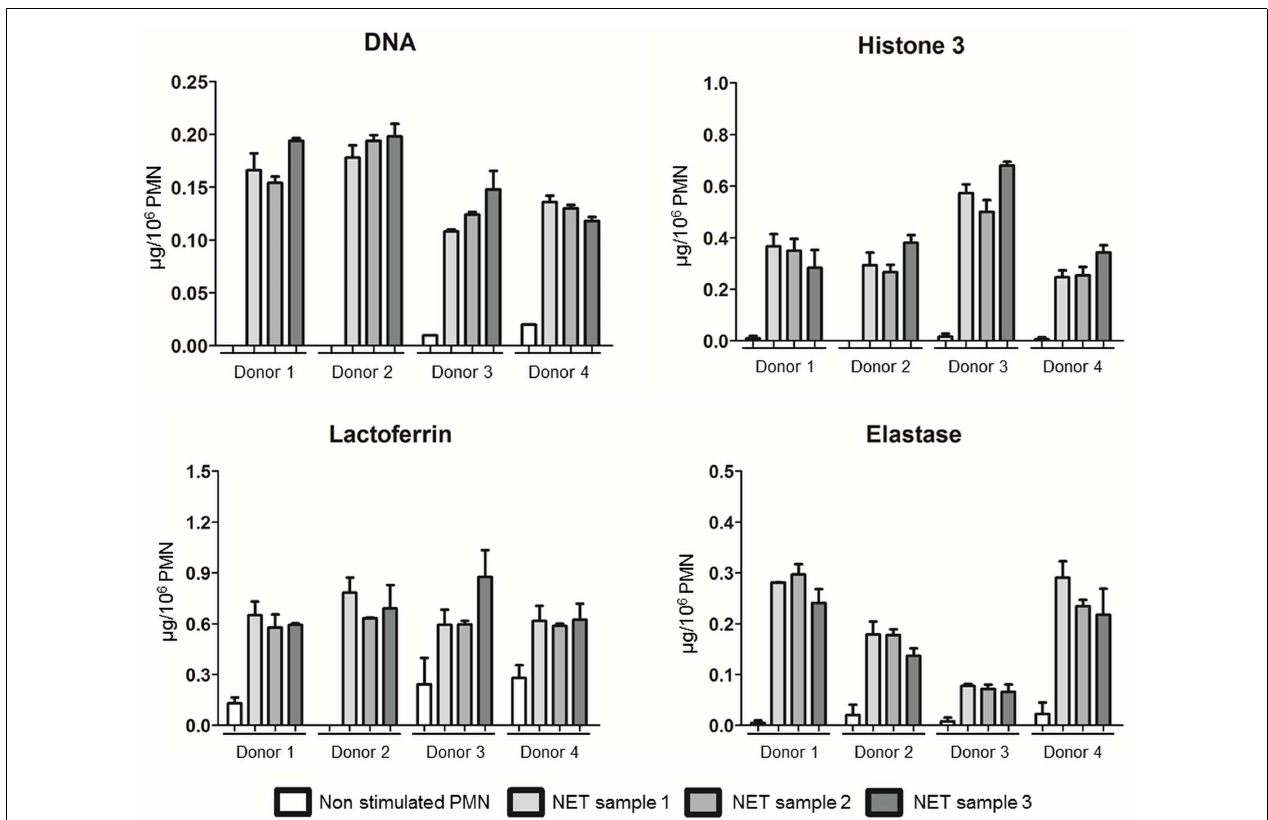
FIGURE 6 | NET preparation and characterization are reproducible . dsDNA, H3, LF, and ELA concentrations of A23187-NET samples from four healthy donors. Each fresh blood sample was divided in three parts, and three independent NET isolations, and characterizations were done. Data are means ± SEM ( n = 3). Results are expressed in µ g/10 6